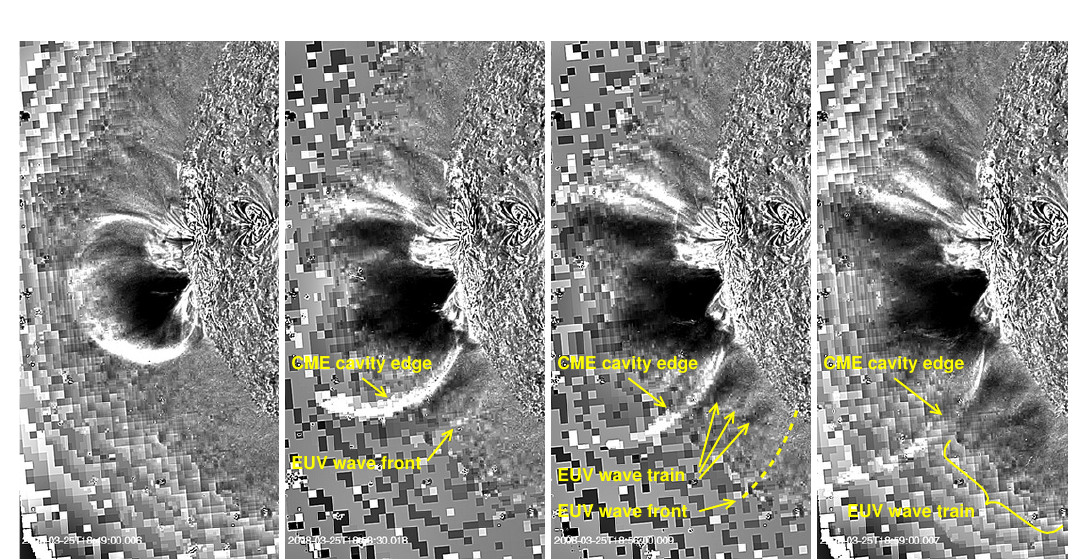
Figure 37: The launch of the coronal wave of 2008 Mar 25 by the lateral expansion of a CME cavity, imaged with EUVI/STEREO at 171 ˚A in base ratio images. It is clearly evident that the EUV wave detaches from the expanding CME flank (from Patsourakos et al. , 2010a).